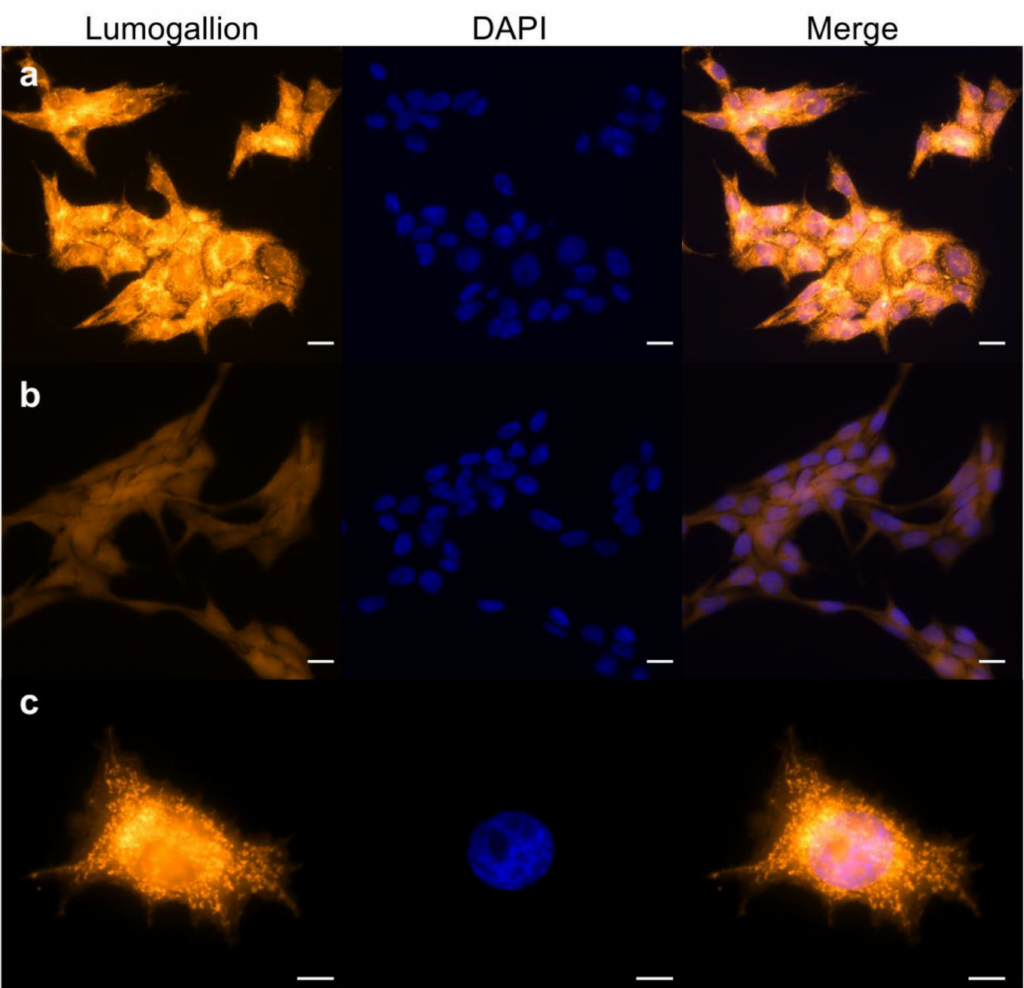
Figure 2. Lumogallion staining of V79 cells exposed to aluminum. The cells were incubated for 3 h with 100 µ m AlCl 3 ( a , c ) or the same volume of vehicle (H 2 O) alone ( b ) in serum-free medium. Fixed cells were stained with Lumogallion (orange) and DAPI (blue). Magnification: 40 × (( a , b )); 63 × ( c ). Scale bars: 20 µ m (( a , b )); 10 µ m ( c